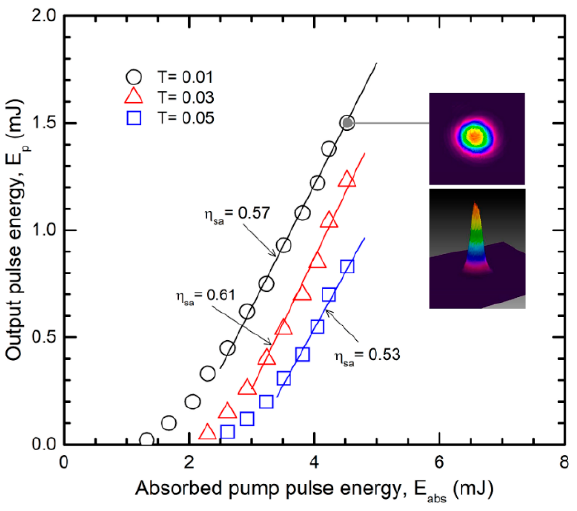
Figure 26. Laser pulse energy (E p ) versus absorbed energy of the pump pulse (E abs ). The laser beam distribution at the highest output level is shown in the figure inset. Reprinted with permission from ref. [44], copyright 2020, Elsevier.